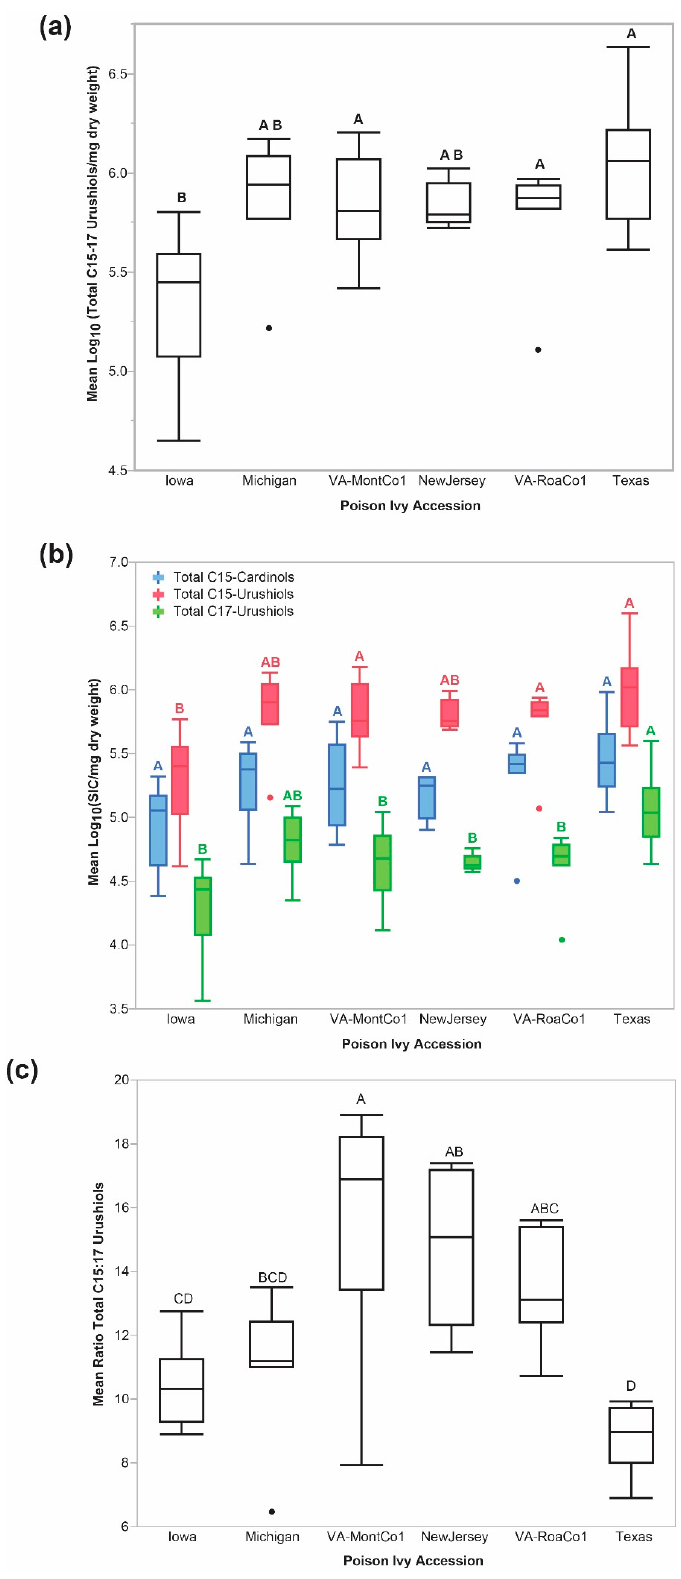
Figure 1. GC-MS analysis of alkylphenol levels in poison ivy accessions. ( a ) combined total C15- and C17-urushiol levels. ( b ) blue, total C15-cardanol; red, total C:15-urushiol; and green, total C17-urushiol levels. ( c ) ratio of total C15:C17 urushiol